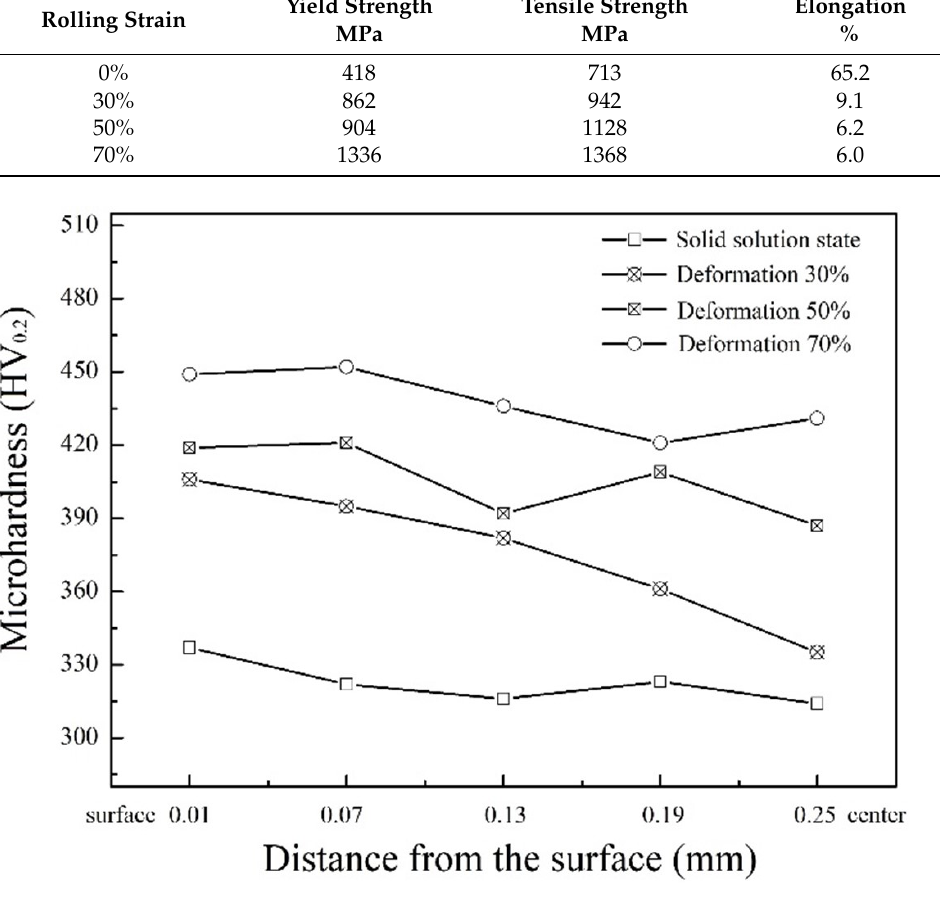
Figure 6. Microhardness distributions along the thickness direction of cold-rolled sheets with different